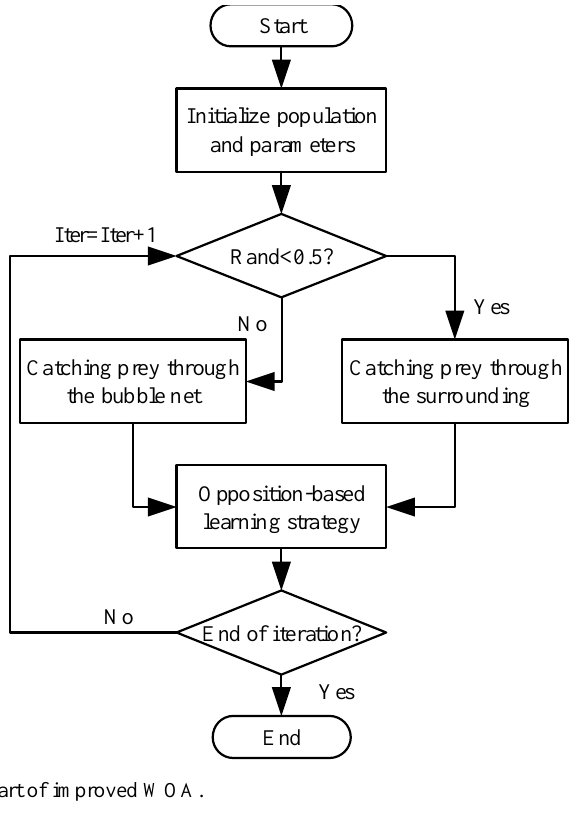
Fig. 1. The flowchart of improved